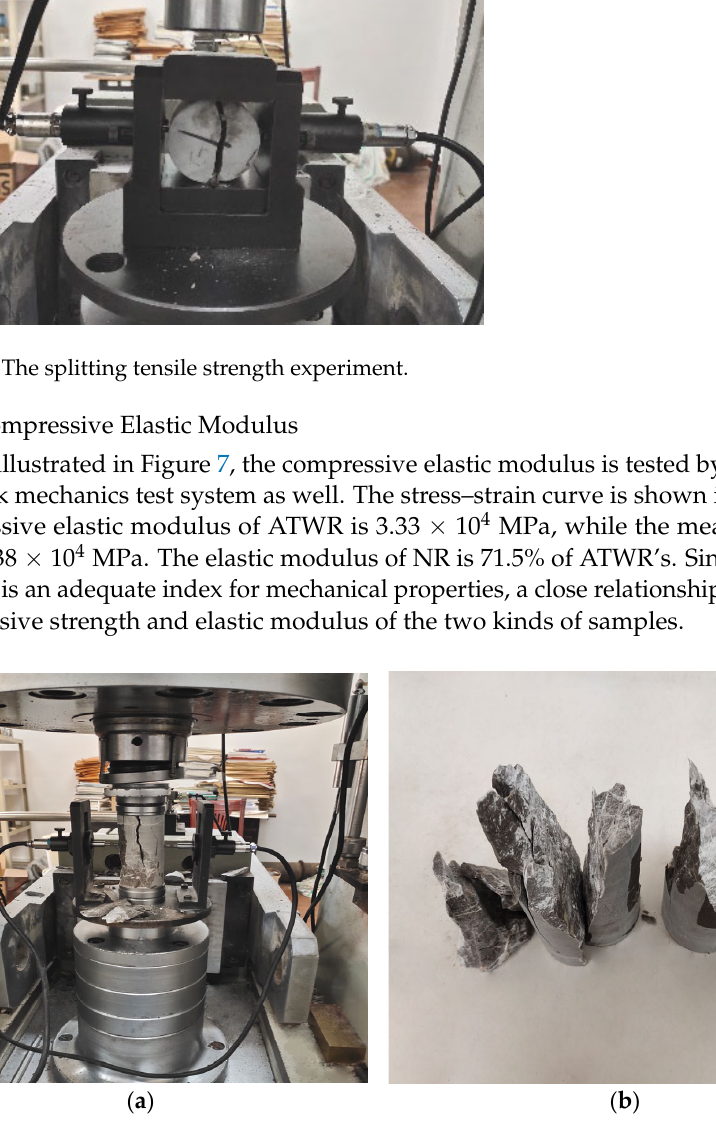
Figure 7. The compressive elastic modulus experiment: ( a ) test instrument; ( b ) failure mode.